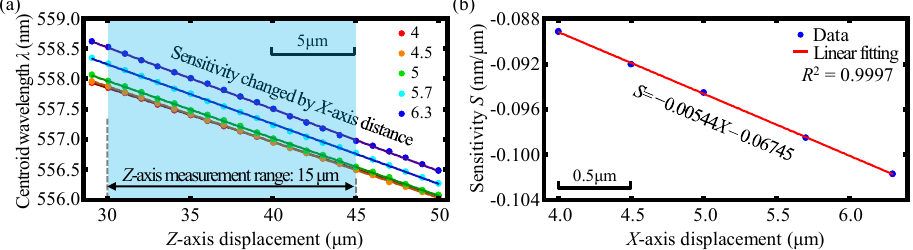
Figure 9. Experimental results of ( a ) the linear relationship between the centroid wavelength λ and Z -axis displacement and ( b ) the linear relationship between the corresponding sensitivity S ( λ -Z curve slope) and X -axis displacement.